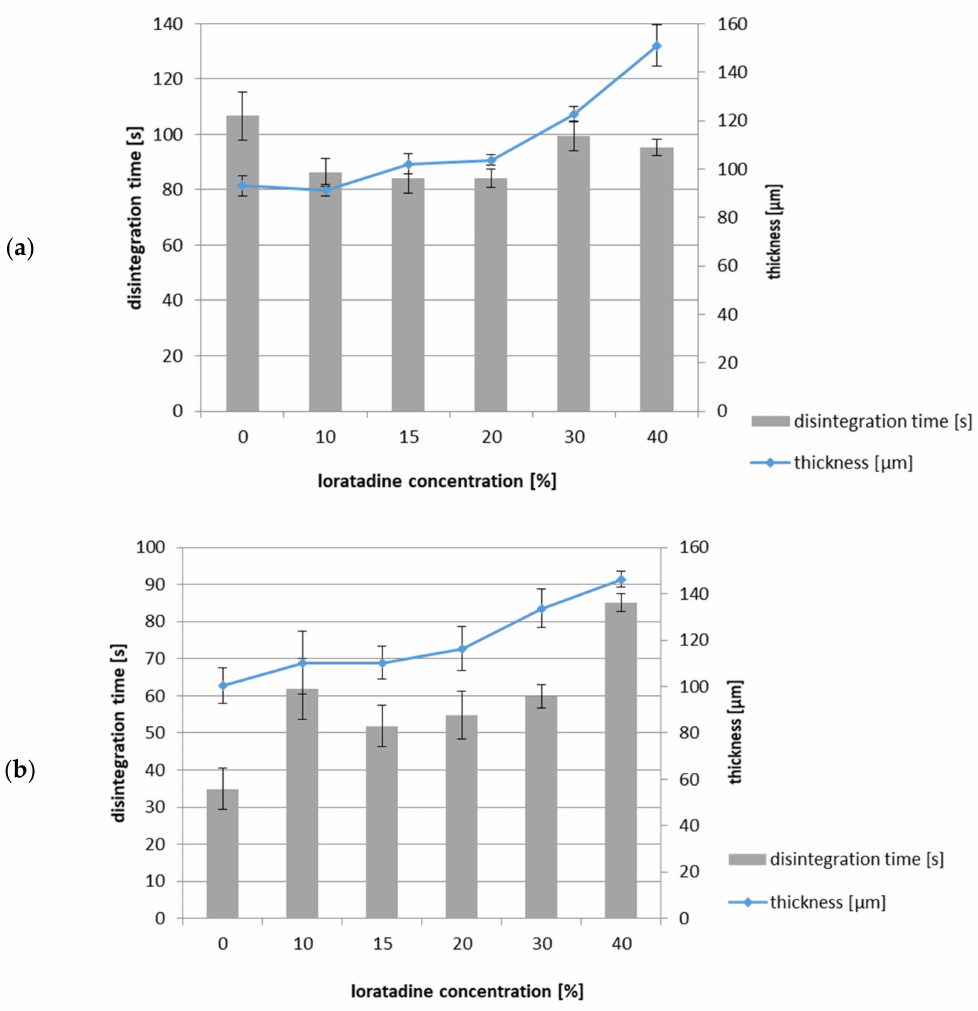
Figure 7. Influence of solid particles loading (LO 0–40% w / w ) on the disintegration time ( n = 3, mean ± SD) and film thickness ( n = 10, mean ± SD) of ODFs prepared with a casting height of 800 µ m: ( a ) HPMC, ( b ) AP / PVP